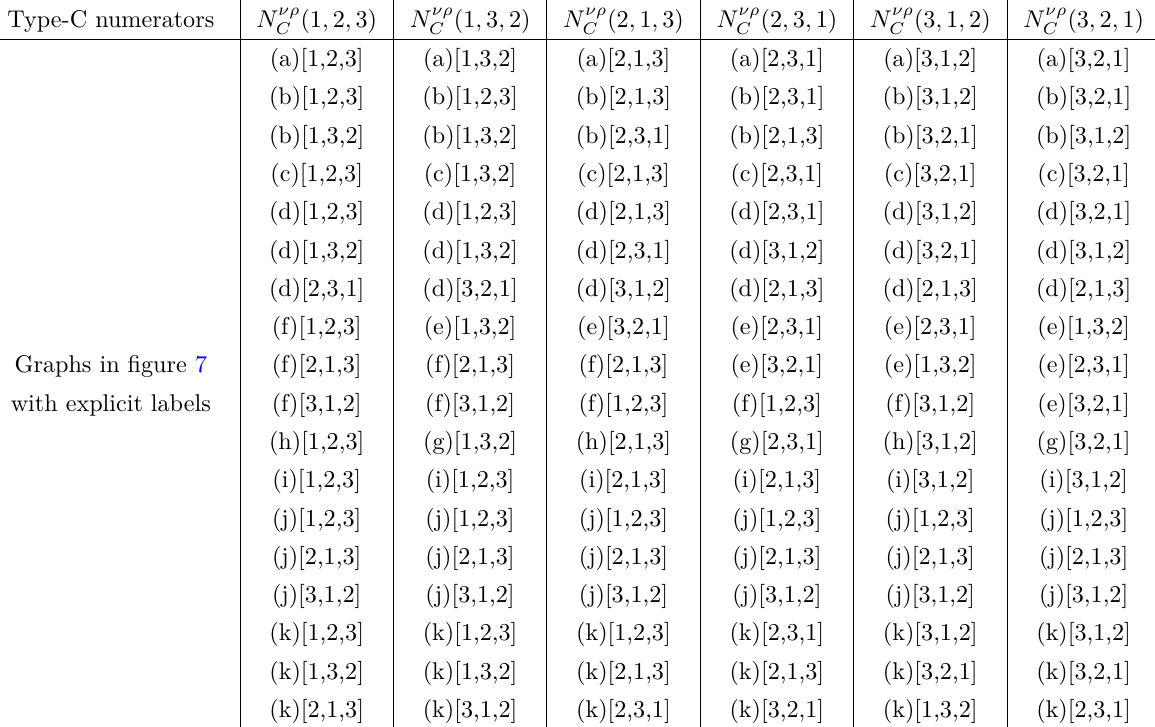
( σ ) where σ ∈ P (1 , 3) . The C